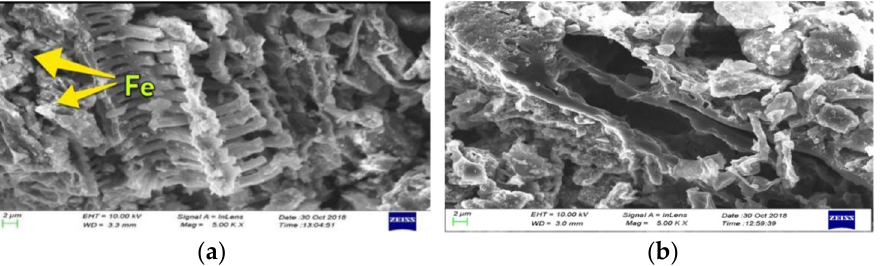
Figure 16. SEM images of Fe-AIL showing ( a ) Fe particles in pores, and ( b ) irregular microgrooves. Reprinted from [25], ©2020 The Authors.